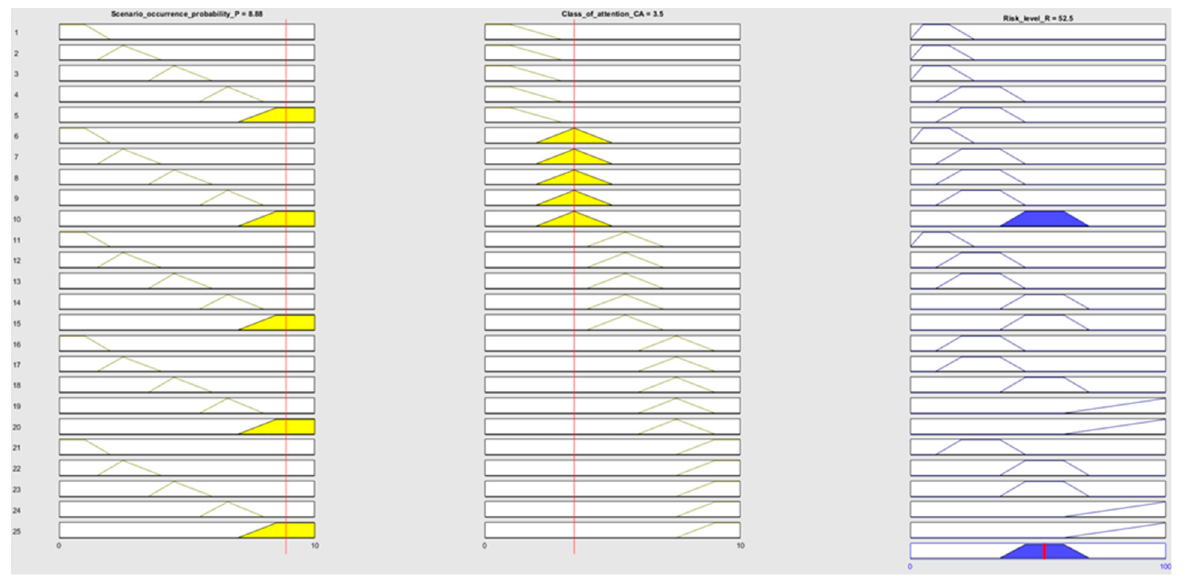
Figure 11. Sample rule base for the proposed fuzzy decision-making